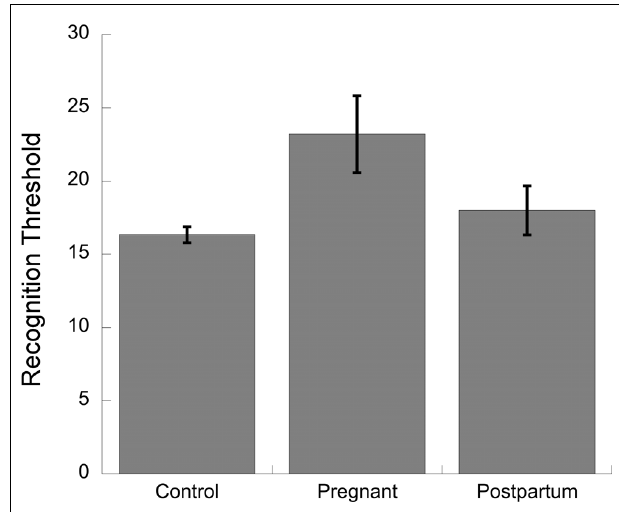
FIGURE 3 | Data from Noferi and Giudizi (1946). Recognition thresholds for non-pregnant, pregnant, and postpartum women. Blast olfactometer was used to determine recognition thresholds for lemon.There were 15 participants per group in a cross-sectional